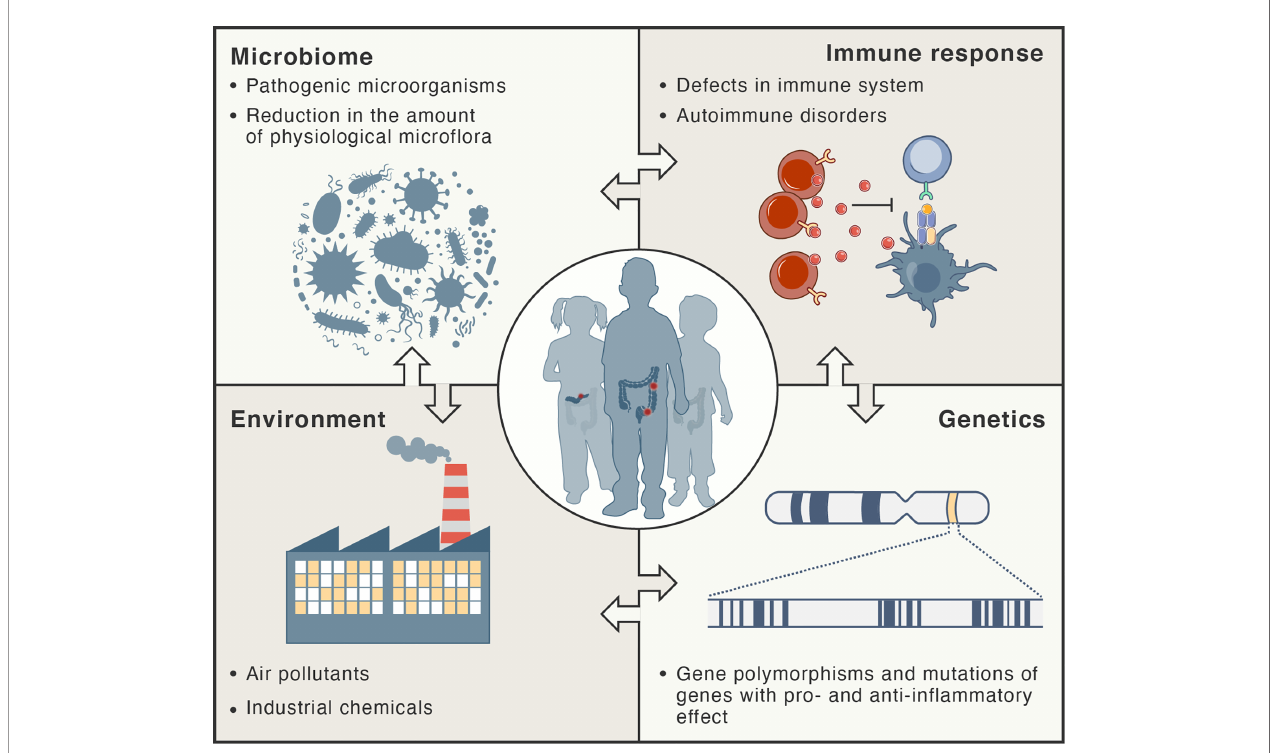
FIGURE 1 | Risk factors for development of chronic in fl ammatory disorders. These types of diseases are thought to develop as result of complex interactions between the immune system, microbiome, and environment in genetically-susceptible